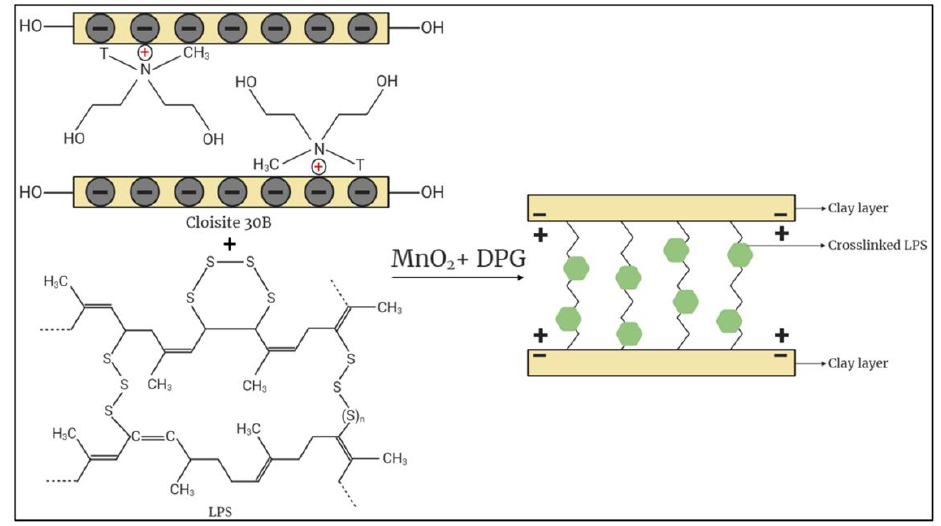
Figure 1. An illustration of the structure of liquid polysulfide/clay nanoparticles (LPS/CNPs) nano- composite.